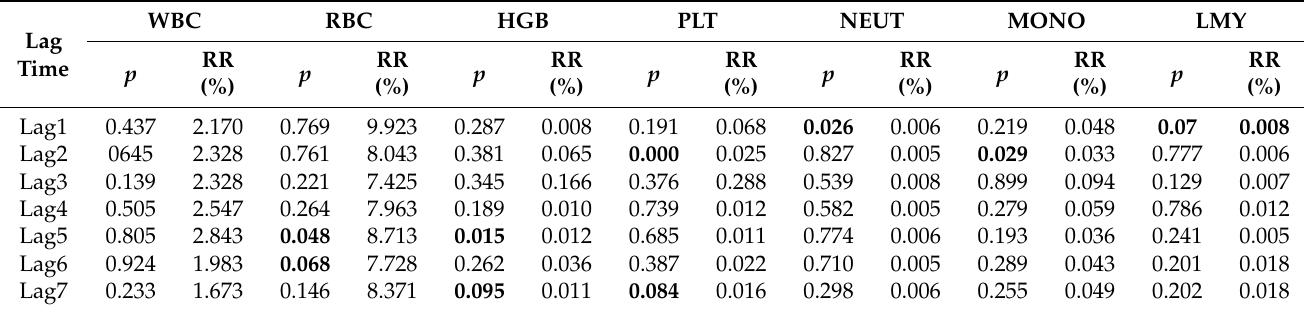
Table 6. Correlation between PM 2.5 and blood routine parameters after different lag times.